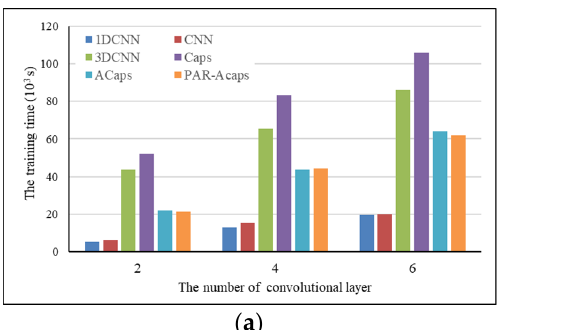
Figure 12. The classification results of SA dataset derived from 1DCNN, CNN, 3DCNN, Caps, ACaps, and PAR-ACaps with four and six convolutional layers.